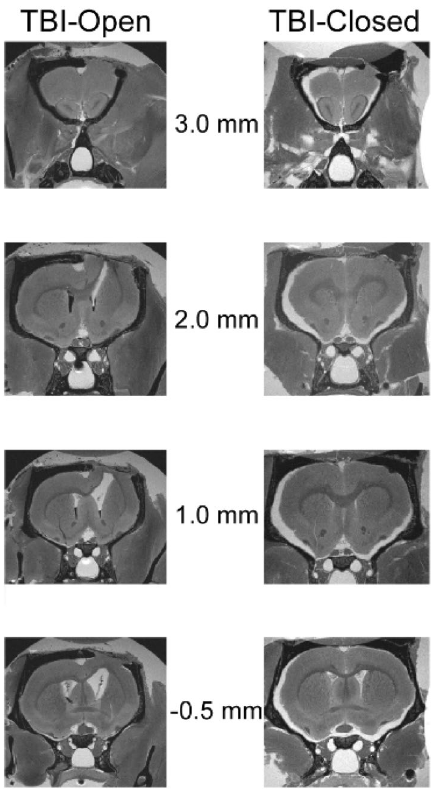
Figure 5. Two rats were scanned post-mortem 4 weeks after a TBI. MRIs were taken with a 9.4 T Varian scanner, using a 38 mm ID quadrature RF coil. To reduce interference between adjacent slices, images were collected in two separate interleaved spin-echo acquisitions (each with TR/TE = 900/11 ms, Number of averages = 150, matrix size = 384 × 384, field of view = 1.92 × 1.92 cm, slice thickness = 0.25 mm, total acquisition time = 14.5 h.). Center column numbers indicate rostro-caudal stereotaxic coordinates relative to the frontal cranial suture line, Bregma. The number between the two columns of MRI figures (3 mm, 2 mm, 1 mm, -0.5 mm) indicate anterior–posterior direction location of the coronal section shown. These are functionally relevant to motor cortex. The rat on the left was given a decompressive craniectomy after TBI (TBI Open Skull Group) while the rat on the right was given a cranioplasty immediately after TBI (TBI Closed Skull Group). In the rat with the decompressive craniectomy (left), cortical tissue herniated out of the cranium whereas cortical anatomy was preserved following open TBI with the cranioplasty procedure